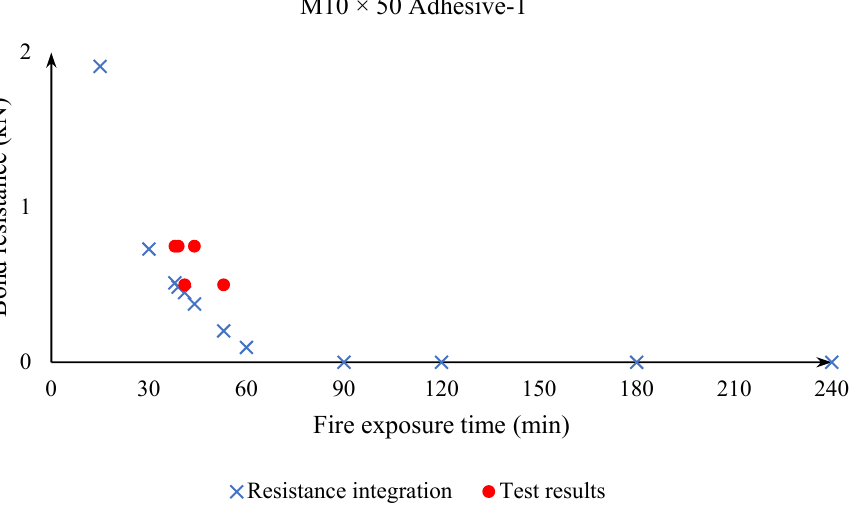
Figure 14. Fire resistance of M10 × 50 bonded anchor using Adhesive-1 after consideration of bond stress beyond T max .